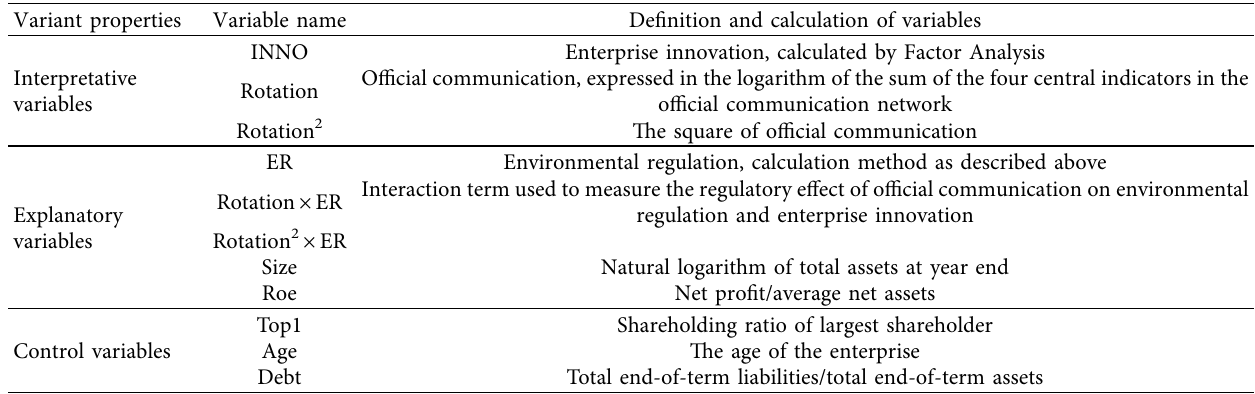
Table 5: Definition of variables.